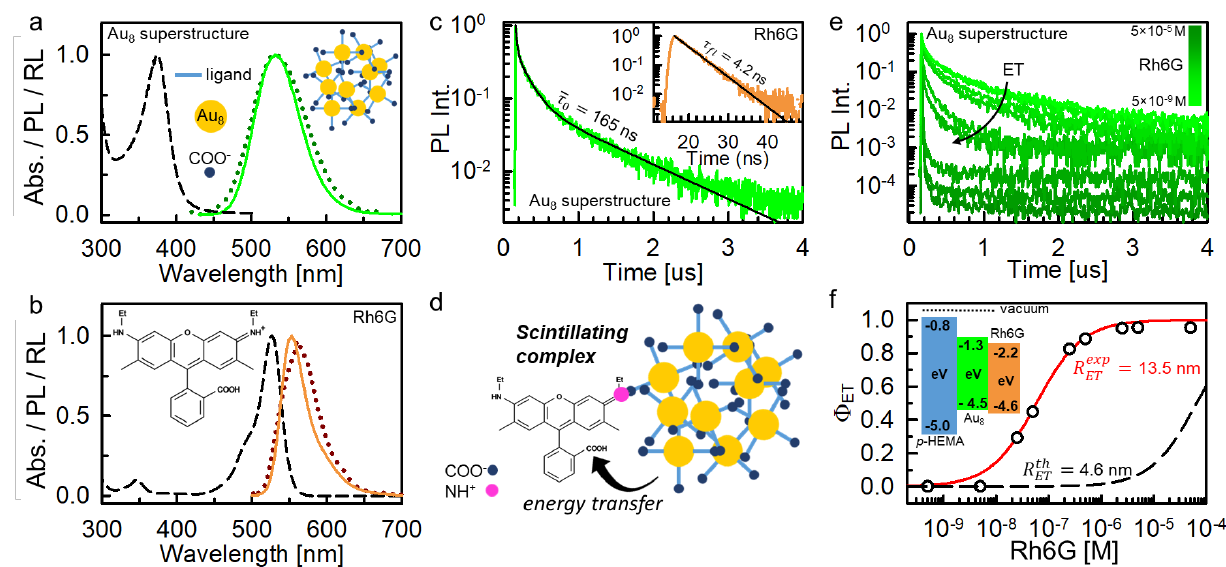
Figure 2. ( a , b ) Absorption (dashed line) and photoluminescence (PL, solid lines) of Au 8 superstructures and rhodamine 6G (Rh6G) in aqueous and ethanol dispersion, respectively. Dotted lines are the corresponding radioluminescence spectra observed under soft X-ray exposure. The insets show the structure of the investigated compounds. ( c ) Time resolved PL at 530 nm spectrum of Au 8 superstructures dispersion under pulsed excitation at 355 nm. The inset show the Rh6G PL decay at 570 nm. Solid lines are the fit of the PL intensity decays data with multi-exponential and single exponential decay functions, respectively. ( d ) Sketch of the sensitizer/emitter complex formed by Au 8 superstructures and the Rh6G dye. ( e ) Time resolved PL at 530 nm spectrum of Au 8 superstructures dispersion under pulsed excitation at 340 nm as a function of the Rh6G concentration in a H 2 O/EtOH mixed solution. ( f ) Au 8 superstructures-to-Rh6G energy transfer yield φ ET as a function of the Rh6G concentration. The solid line is the fit of the experimental data with a diffusion-mediated energy transfer process kinetic model with characteristic interaction radius of 13.6 nm. The dashed line is the theoretical efficiency curve calculated from the absorption and PL properties of the investigated compounds with an interaction radius of 4.6 nm. The inset shows the HOMO/LUMO energies expressed in eV for the host polymer p-HEMA, the Au 8 clusters and the Rh6G dye with respect to the vacuum level.